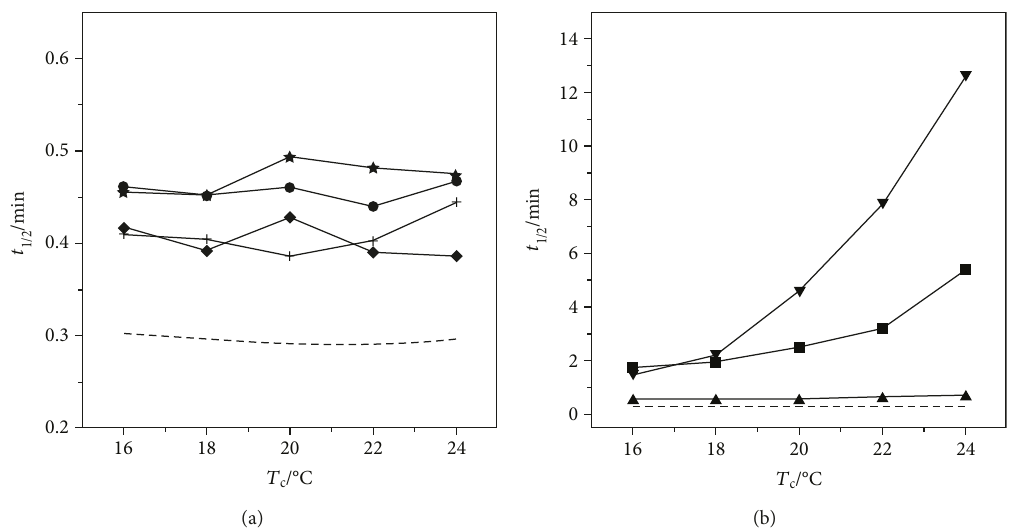
Figure 9: Dependence of t with the isothermal crystallization temperature ( T 1/2 linear PCL, ( + ) SCL4, ( ♦ ) SCL3, ( ● ) SCL2, and ( ★ ) SCL1 and (b) linear PCL and HEMACL# copolymers, symbols: ( − ) linear PCL, ( ▲ ) HEMACL1, ( ■ ) HEMACL2, and ( ▼ ) HEMACL3.